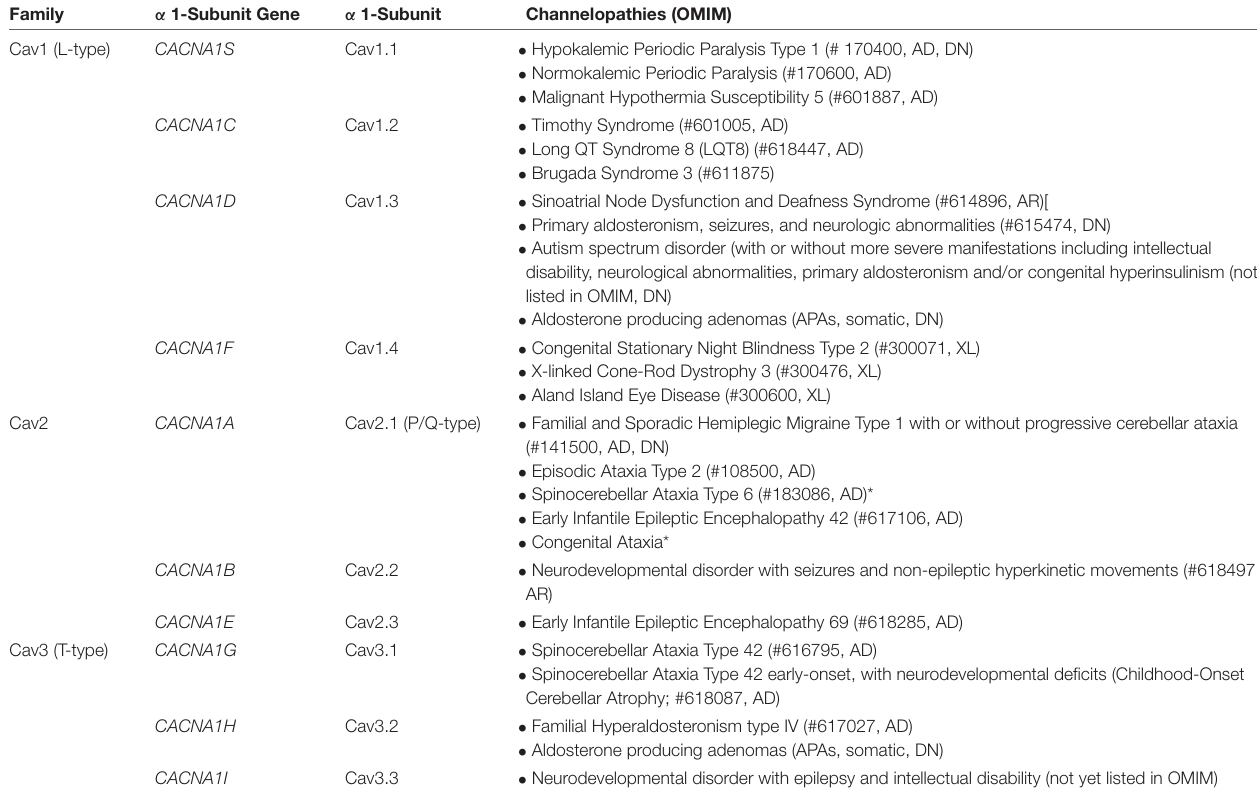
TABLE 1 | Voltage-gated Ca 2 + channels: classification and human genetic diseases.